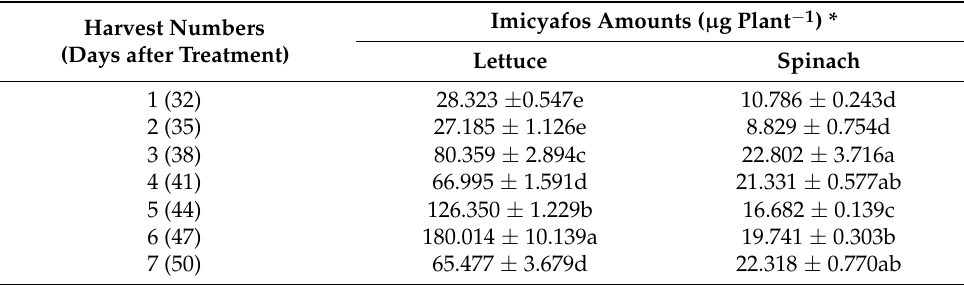
Table 4. Residual patterns of imicyafos amounts in plant during the harvest